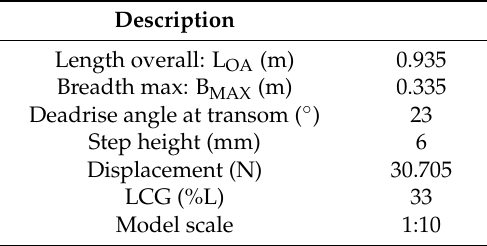
Table 1. The C03 model details.